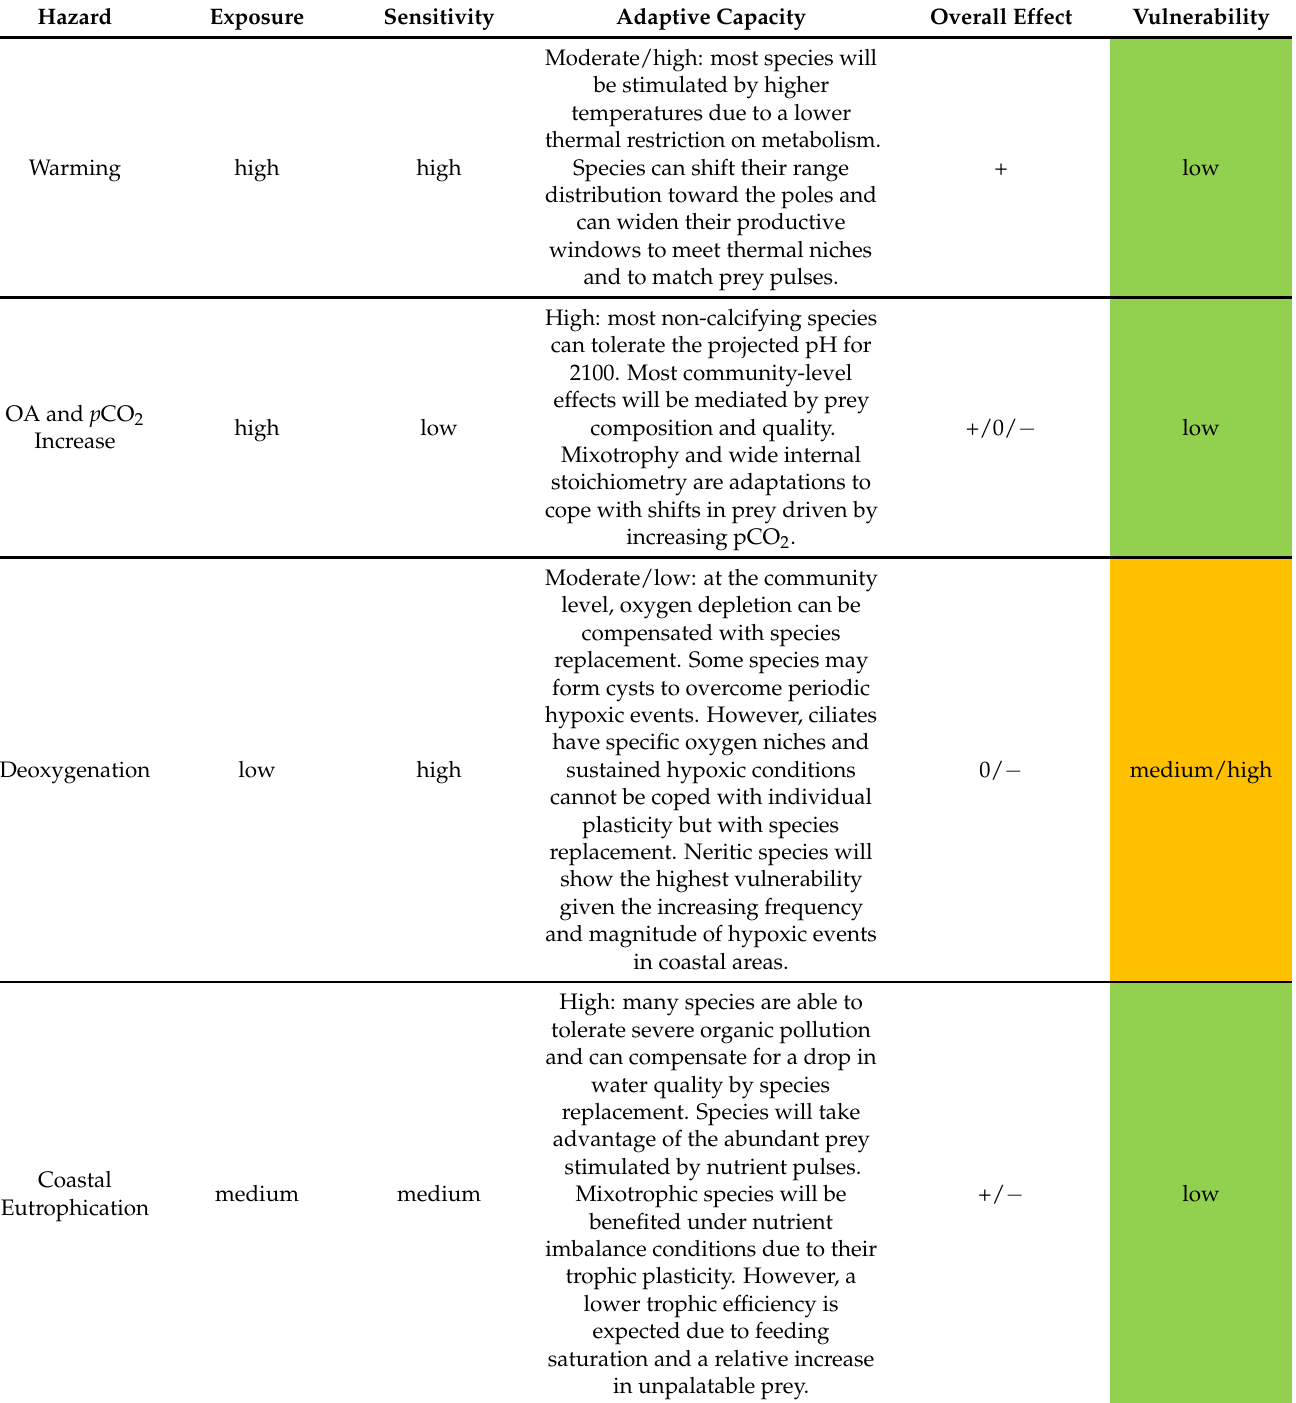
Table 2. Associated vulnerability of microzooplankton to the main global hazards: exposure, sensitivity, and adaptive capacity define the level of vulnerability, which in turn determines the global risk of assessed communities. Hazard Exposure Sensitivity Warming high high